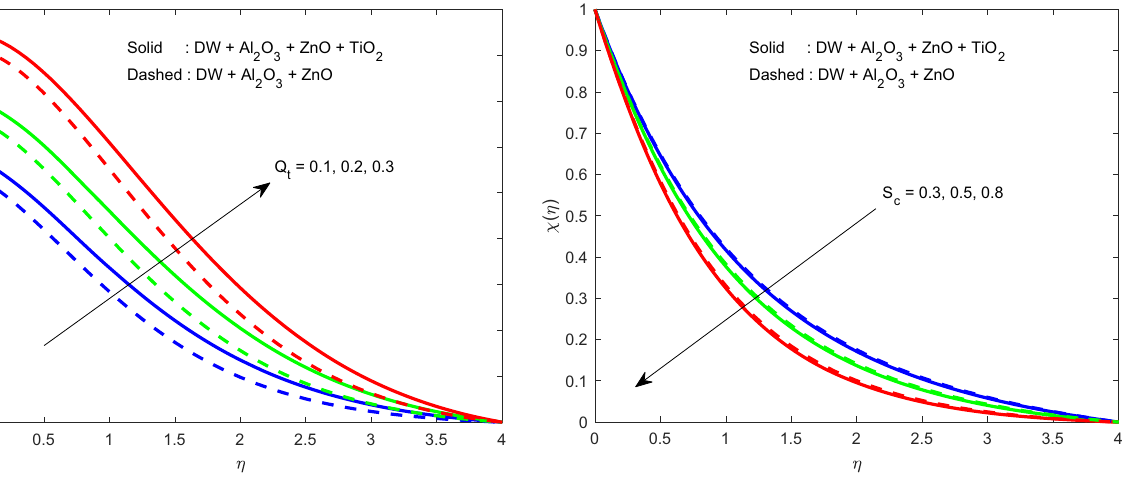
Figure 12: Increasing e ff ects of S c on χ ( η ) .